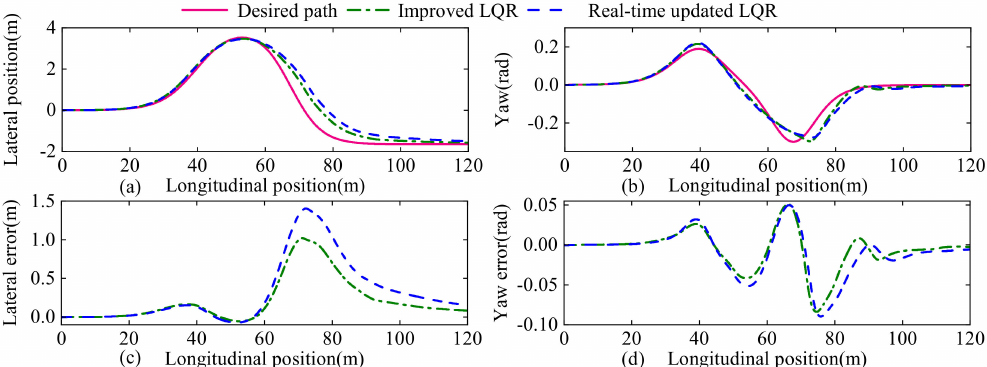
Figure 25. Performance comparison between the improved LQR and the real-time updated LQR under the velocity of 25 m/s: ( a ) lateral position; ( b ) yaw; ( c ) lateral error; ( d ) yaw